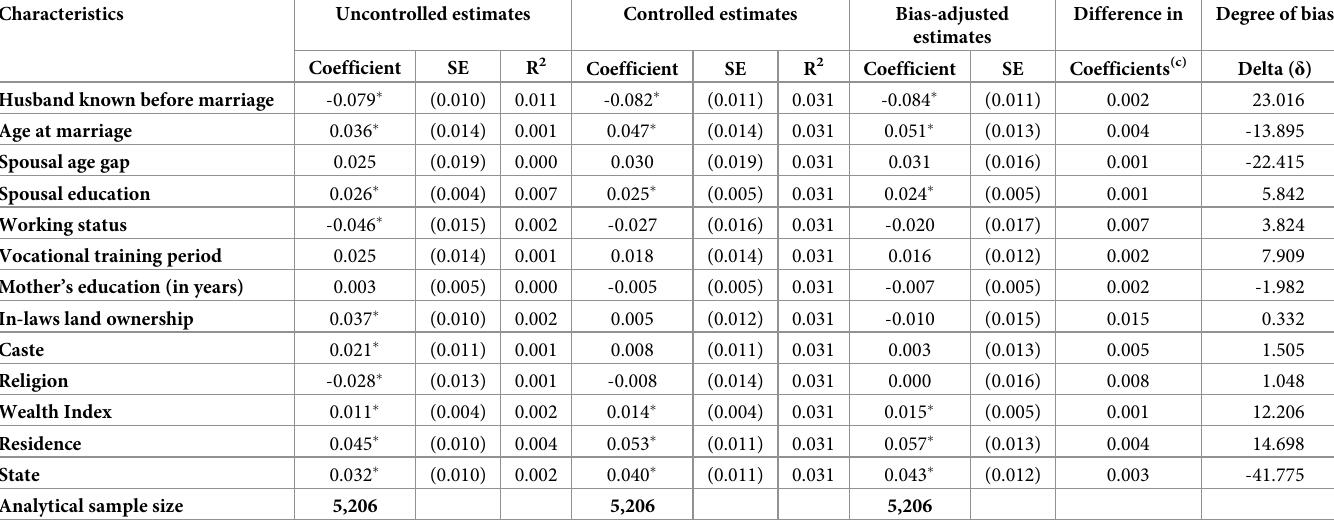
Table 4. Coefficient stability results of the Linear probability model estimates for the multivariable association between dowry payment and explanatory characteristics.